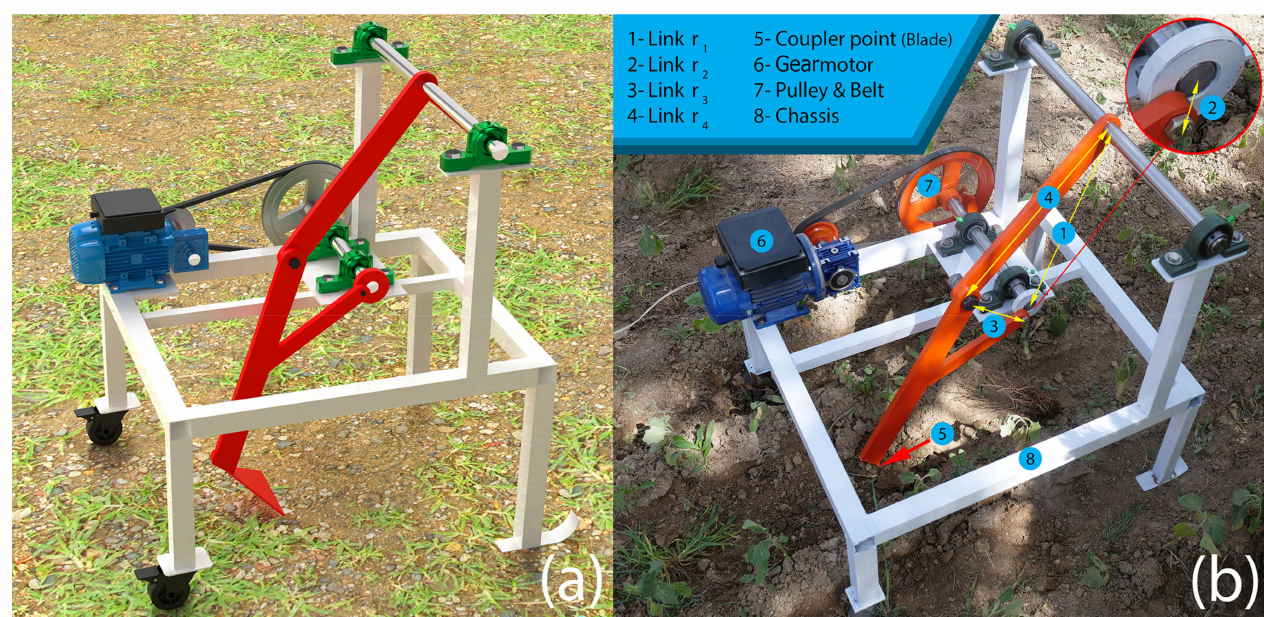
Figure 14. The four-bar cultivator: ( a ) 3D model, and ( b ) developed